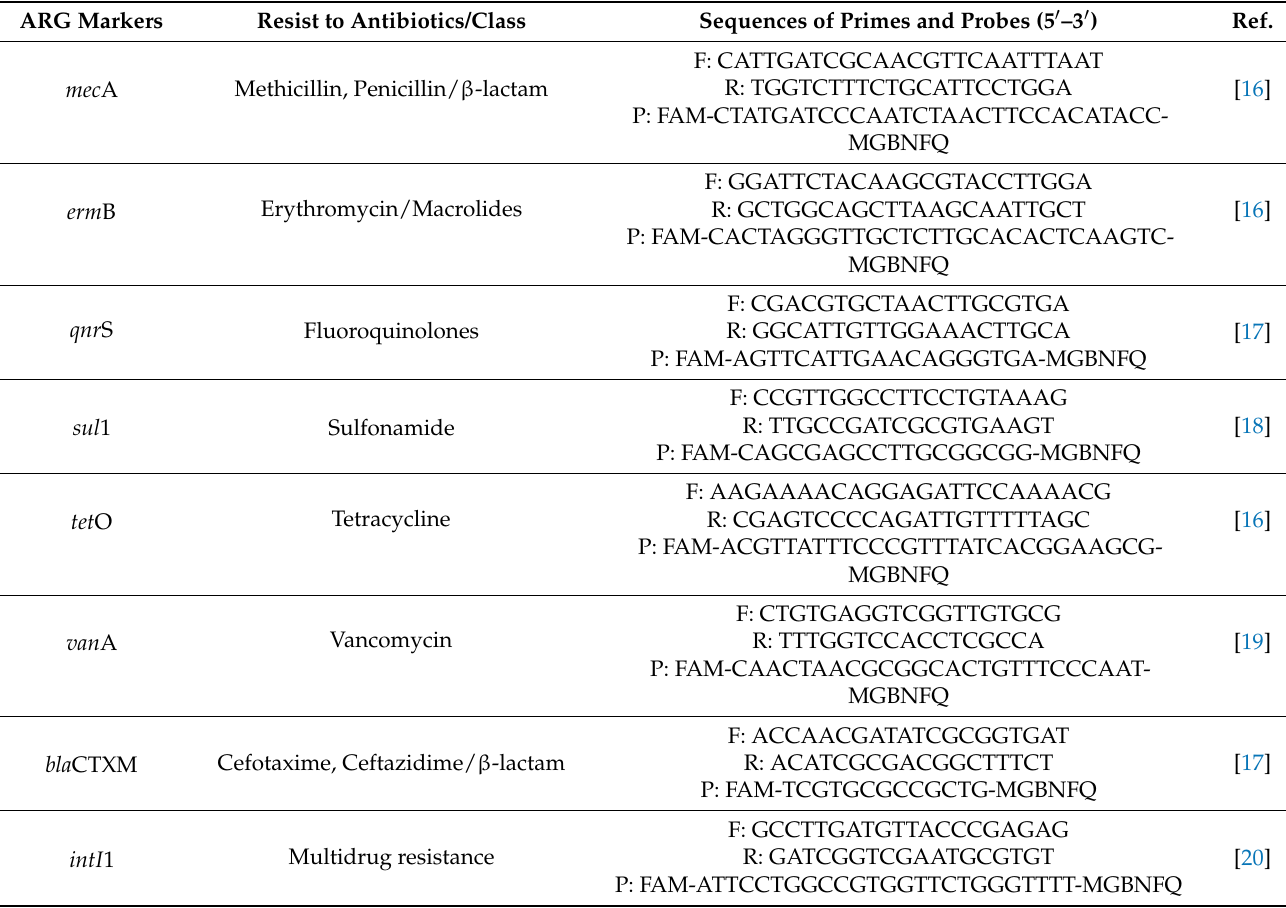
Table 1. ARG markers used in the assay with sequence information of primers (F, forward primer; and R, reverse primer) and probes (P, TaqMan